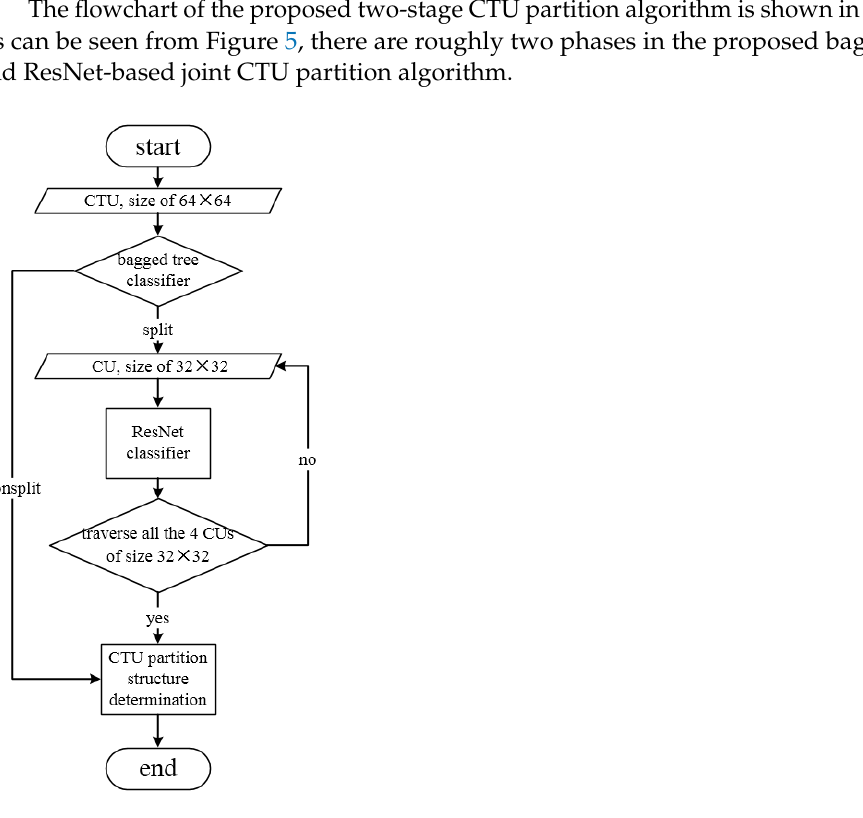
Figure 5. Flowchart of the proposed bagged tree and ResNet-based joint fast CTU partition